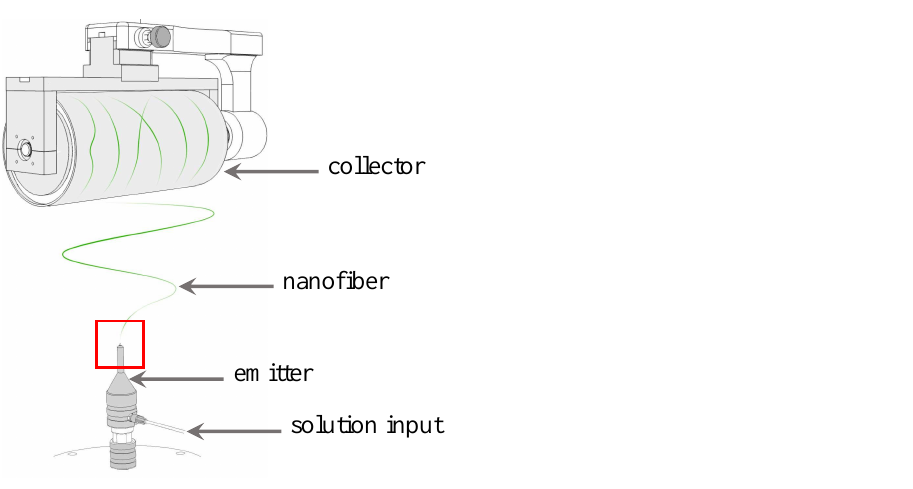
Figure 3. Illustration of the method of electrospinning in the form of a single needle acting as an emitter and a rotating cylinder acting as a collector, on which the nanofiber is gradually wound, and as a result it then creates a kind of fabric that can be used as the basis of a simple nanogenerator [17]. The red square highlights the emitter—the needle with the solution changing to a fiber, which was also described in Figure 2.